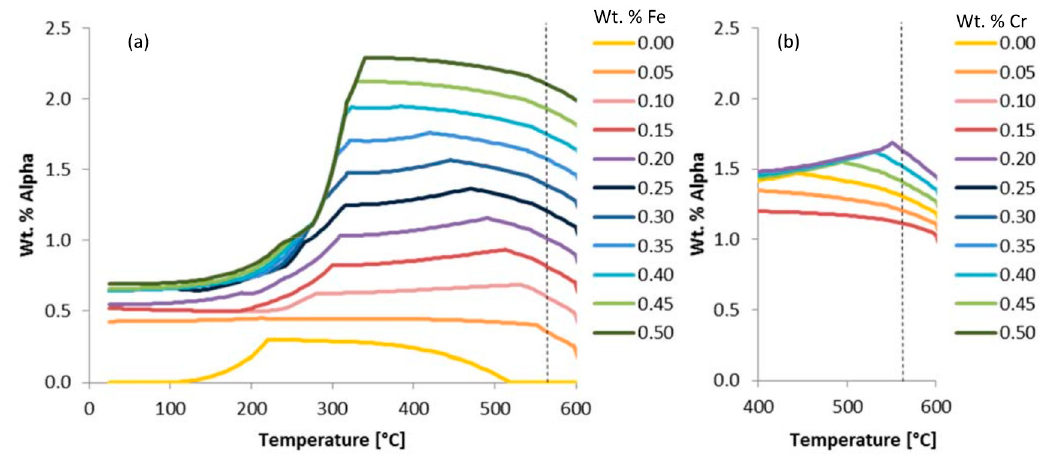
Figure 7. Variation of predicted equilibrium alpha phase in Al 6061 with a content variation of Fe, as shown in ( a ), and a content variation of Cr, as shown in ( b ). The temperature of 575 °C is represented by the dashed vertical lines in ( a , b ).